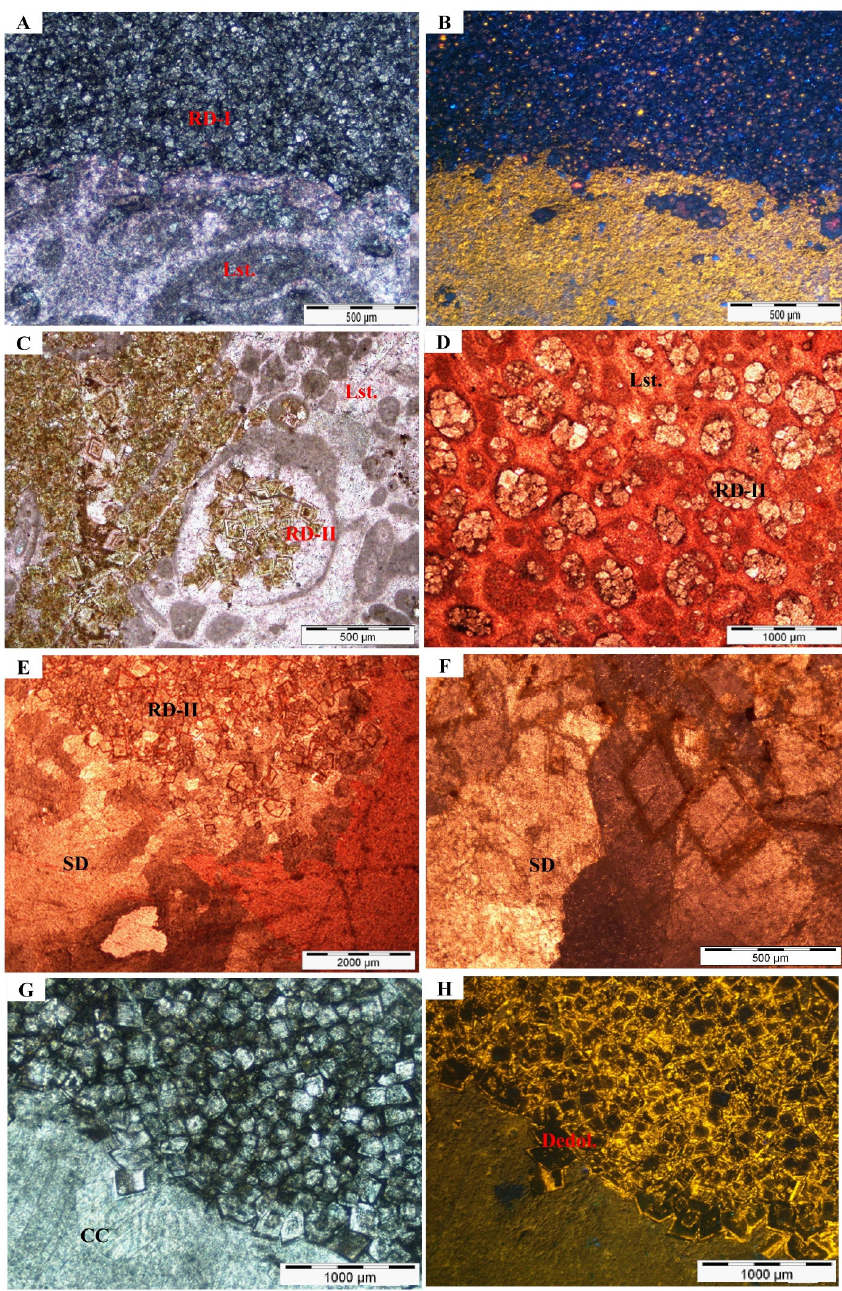
Figure 4. Petrographic features of the dolomite phases observed in the formation. ( A , B ) XPL and corresponding CL photomicrographs of the matrix dolomite (RD-I) show its small crystal size and non-luminescent nature. Note that the bright yellow nucleus of the dolomite crystal growth is clearly visible. ( C ) A PPL photomicrograph of the replacive dolomite cement (RD-II) following the weak planes; the plane nature and concentric growth along the crystals are clearly visible. ( D ) An XPL photomicrograph of a stained thin section shows the replacement dolomite cement (RD-II). Note that it is filling void spaces present in the host limestone. ( E ) An XPL photomicrograph of the saddle dolomite SD shows curved crystal faces and undoluse extinction present in association with the re- placive dolomite (RD-II). ( F ). Inset detail photomicrograph of the saddle dolomite showing the crystal overgrowing the replacive dolomite RD-II. ( G , H ) The XPL and corresponding CL photomicrograph show the bright yellow luminescence of the crystal faces characteristic of dedolomtiztion. Note that the outer rims show brighter